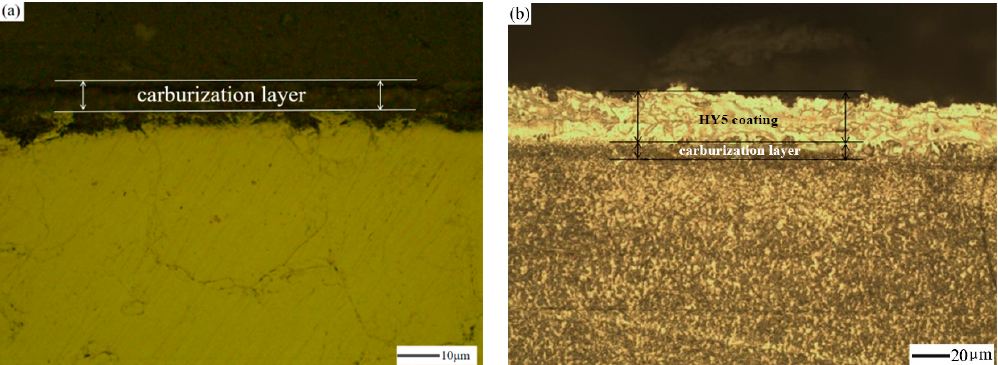
Figure 2. Metallography of the cross-sectional morphologies: ( a ) carburized Ni-based single-crystal superalloy; ( b ) carbur- ized Ni-based single-crystal superalloy with an HY5 coating.